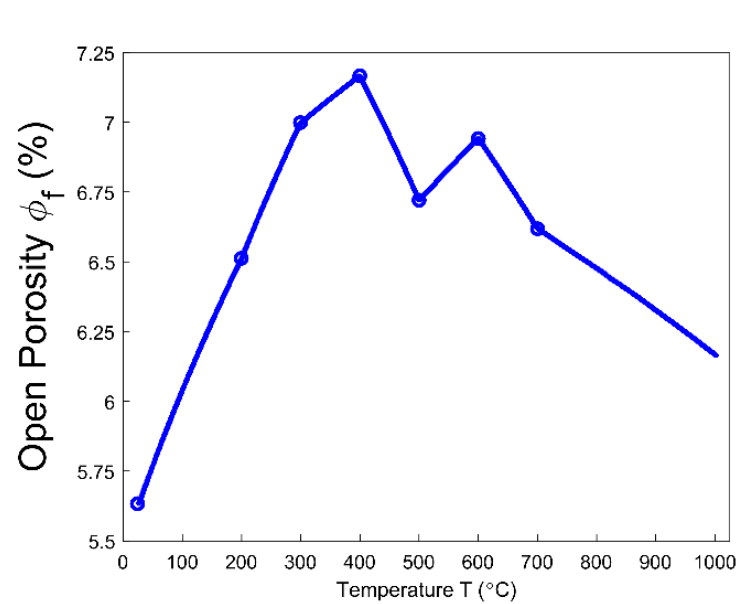
Figure 13. Open porosity.